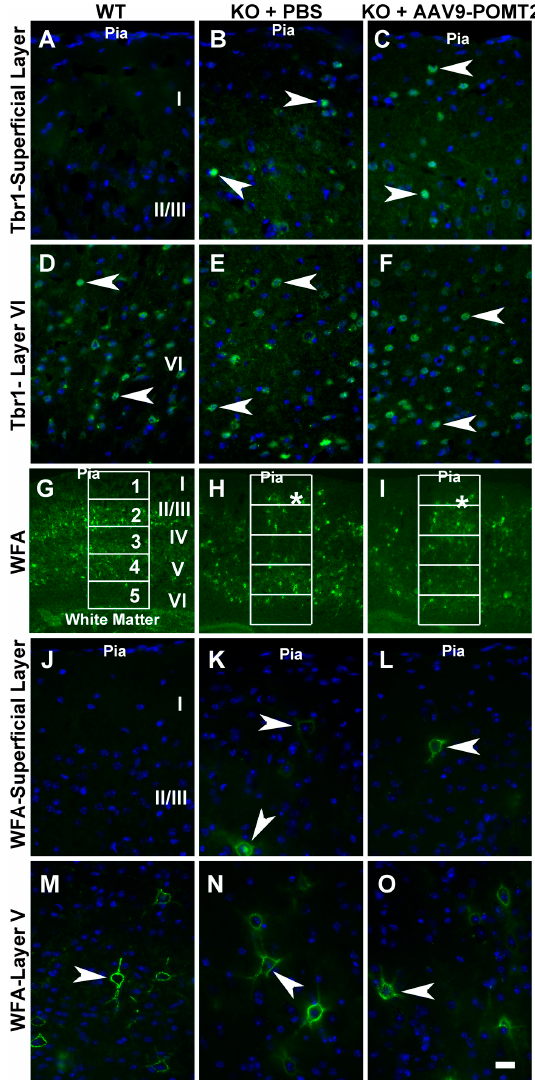
Figure 5. Lamination defects in the neocortex of the knockout mice were not rescued by postnatal AAV9-POMT2 treatment. Brains of PBS-treated wildtype and knockout mice and AAV9-POMT2-treated knockout mice at three to five months of age were sectioned in the coronal plane and stained with antibody against: T-box brain protein 1(Tbr1) ( A – F ); and wisteria floribunda lectin (WFA) ( G – O ). All images were from the neocortical wall at the level of the anterior commissure. ( A – C ) Superficial layers of wildtype, PBS-treated knockout, and AAV9-POMT2-treated knockout mice. Tbr1-positive nuclei were found at superficial regions of neocortex in the knockout mice treated with PBS or AAV9-POMT2 but were never observed in layer I–II/III of wildtype mice. ( D – F ) Layer VI of wildtype and corresponding locations of PBS-treated knockout and AAV9-POMT2-treated knockout mice. Tbr1-positive nuclei were observed in the wildtype mice and the knockout mice treated with PBS and AAV9-POMT2. ( G – I ) Neocortical wall of wildtype and PBS- or AAV9-POMT2-treated knockout mice. WFA-labeled neurons in the knockout mice were disorganized with some near the pial surface (asterisks). ( J – L ) Superficial layers of wildtype, PBS-treated knockout, and AAV9-POMT2-treated knockout mice. WFA-labeled neurons were rarely found near the pial of wildtype mice but frequently observed in PBS-treated and AAV9-POMT2-treated knockout mice (arrowheads). ( M – O ) Layer V of wildtype and corresponding location in the knockout mice. WFA-labeled neurons were clearly observed in wildtype mice and PBS- and AAV9-POMT2-treated mice. KO, knockout; WT, wildtype. Scale bar: 20 µ m ( A – F , J – O ); 160 µ m ( G – I